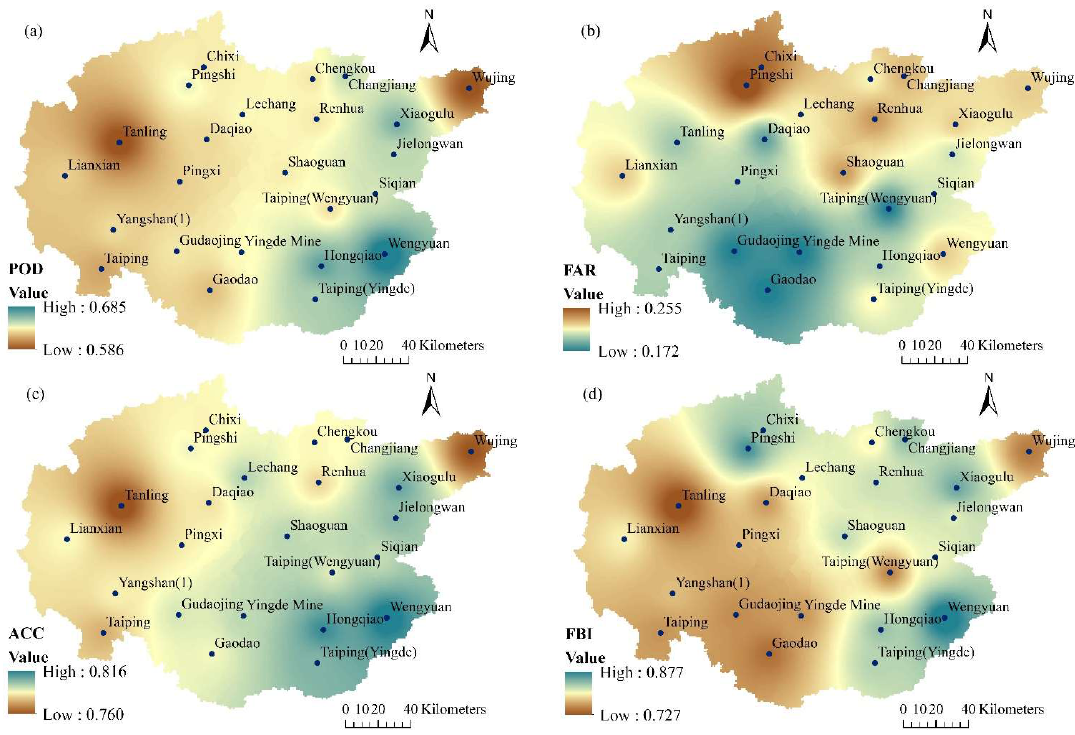
Figure 2. Spatial distributions of the four detected statistical indices: ( a ) POD; ( b ) FAR; ( c ) ACC; and ( d ) FBI.